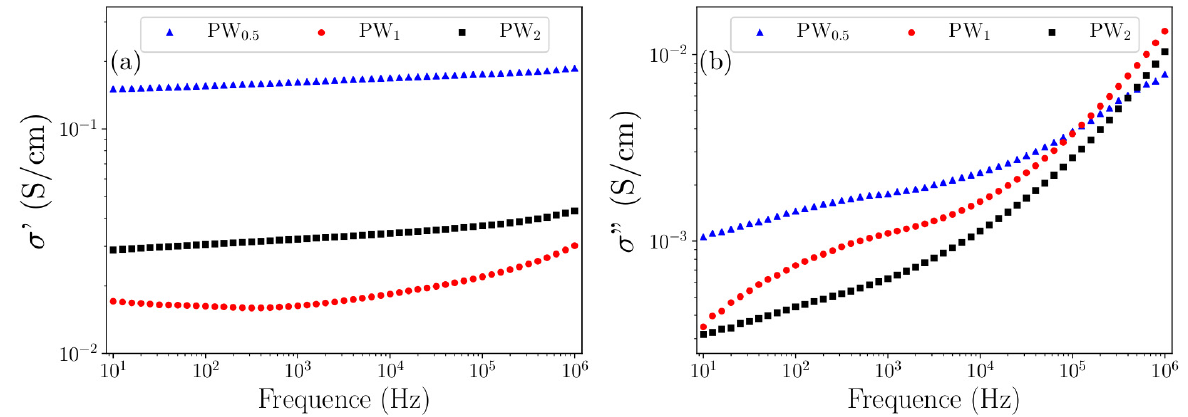
Figure 7. ( a ) Real and ( b ) Imaginary complex conductivity spectrum of nanocomposites.